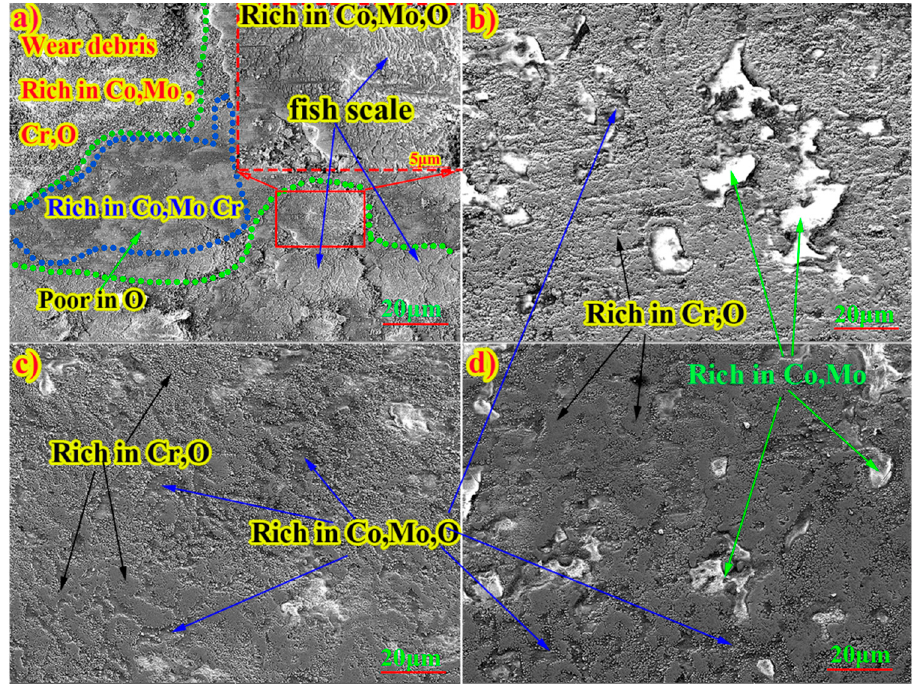
Figure 12. Elemental maps of oxides layer of CoMoCrSi coatings annealed for 3 h.